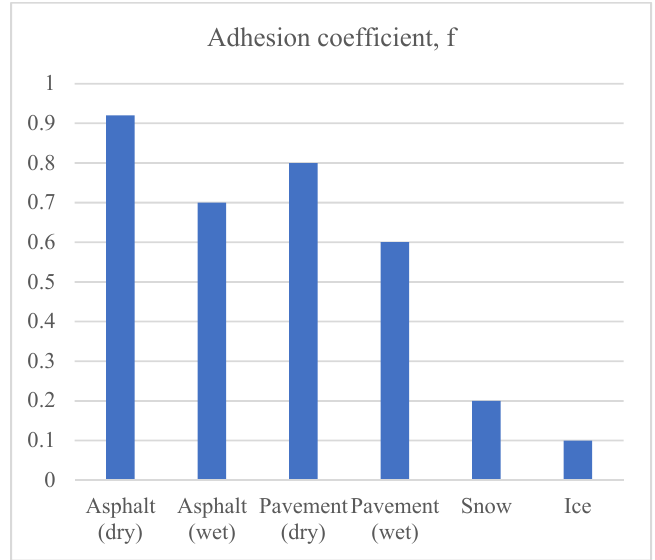
Figure 7. Adhesion coefficient (f) for different road types/conditions.